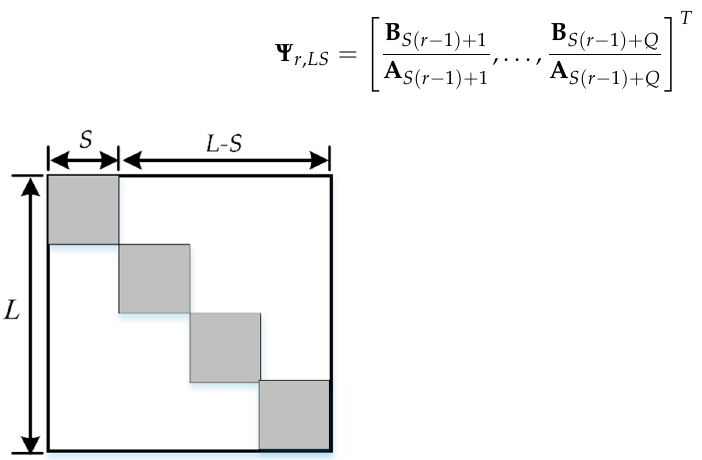
Figure 5. Banded structure of the channel autocorrelation matrix ΨΨ Φ .